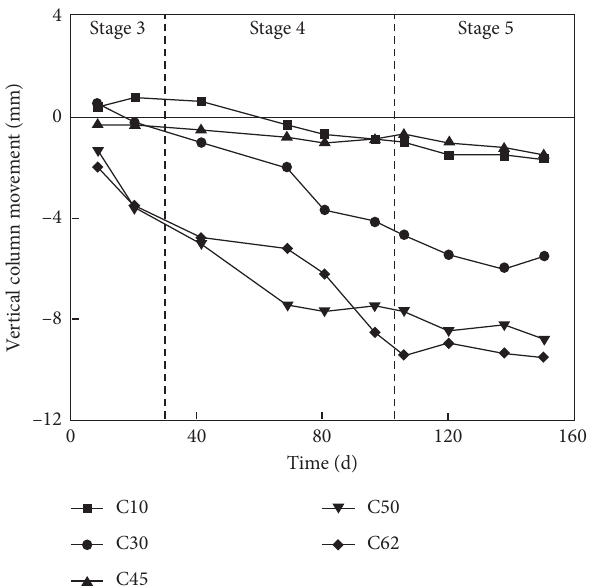
Figure 7: Typical vertical column